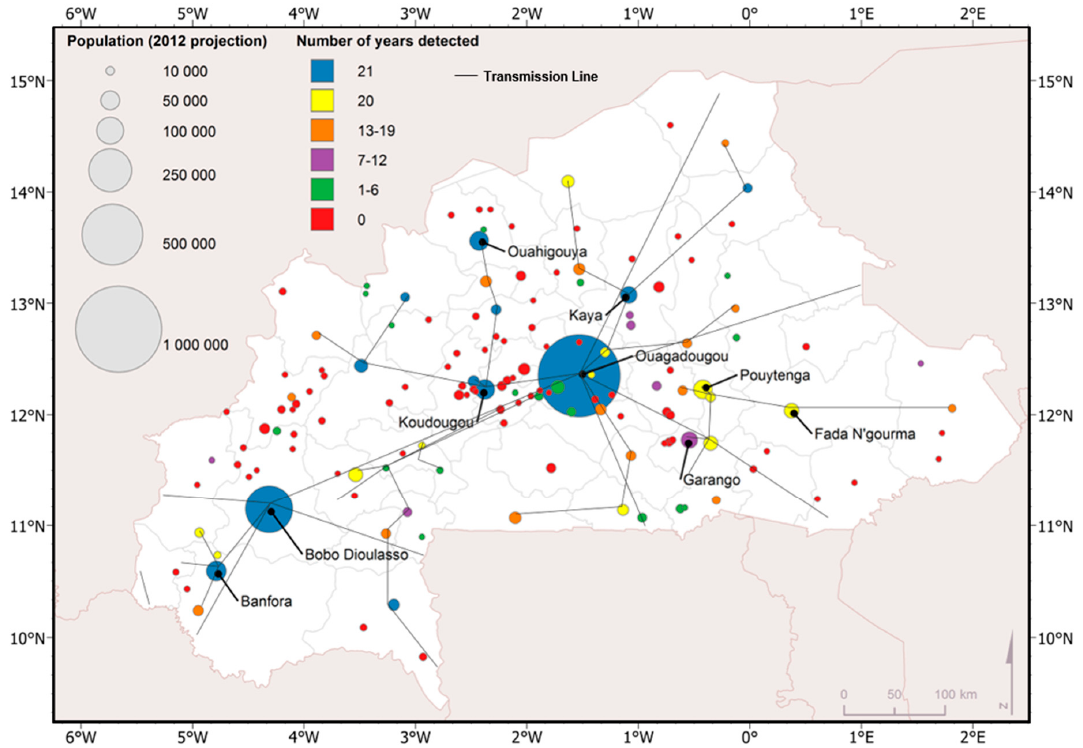
Figure 2. Detection rates of DMSP-OLS nighttime light data, population of communities, and the network of transmission lines in Burkina Faso.